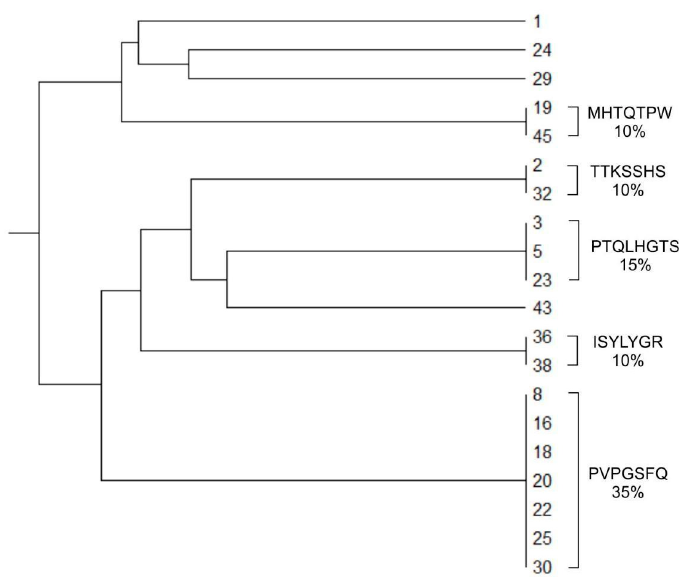
Figure 1. Phylogenetic tree built on the basis of nucleotide sequences of peptides displayed by bacteriophages obtained by screening the Ph.D.-C7C library in vitro on U-87 MG cells, using the Unweighted Pair Group Method with Arithmetic Mean (UPGMA method) and the MEGA X software.